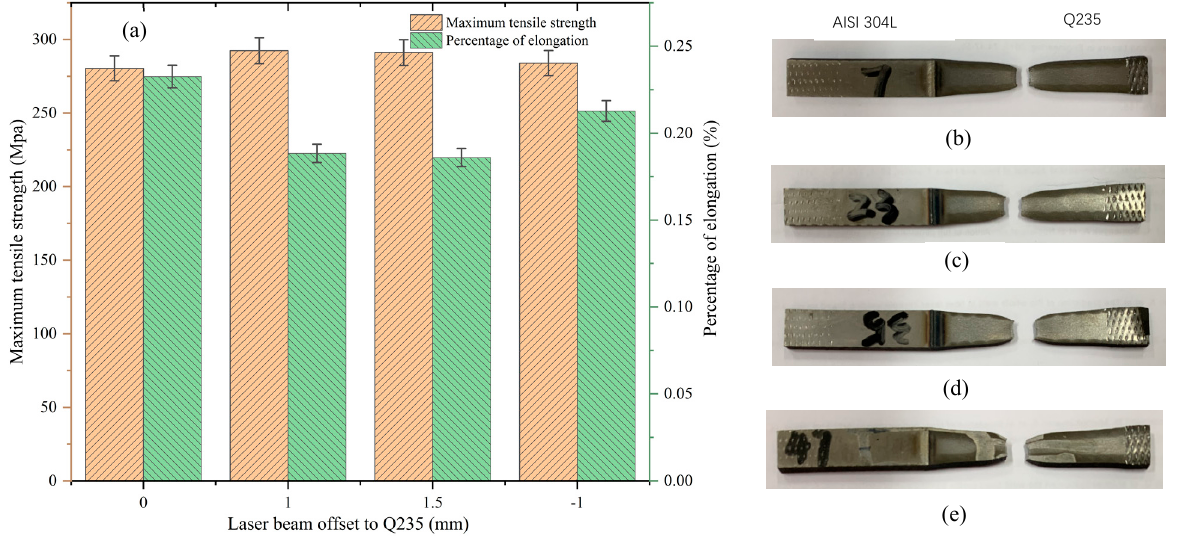
Figure 15. The tensile strength curves and fractured positions of samples with different laser beam offsets: ( a ) tensile strength curves; ( b ) laser beam offset = 0 mm; ( c ) laser beam offset = 1 mm; ( d ) laser beam offset = 1.5 mm; ( e ) laser beam offset = − 1